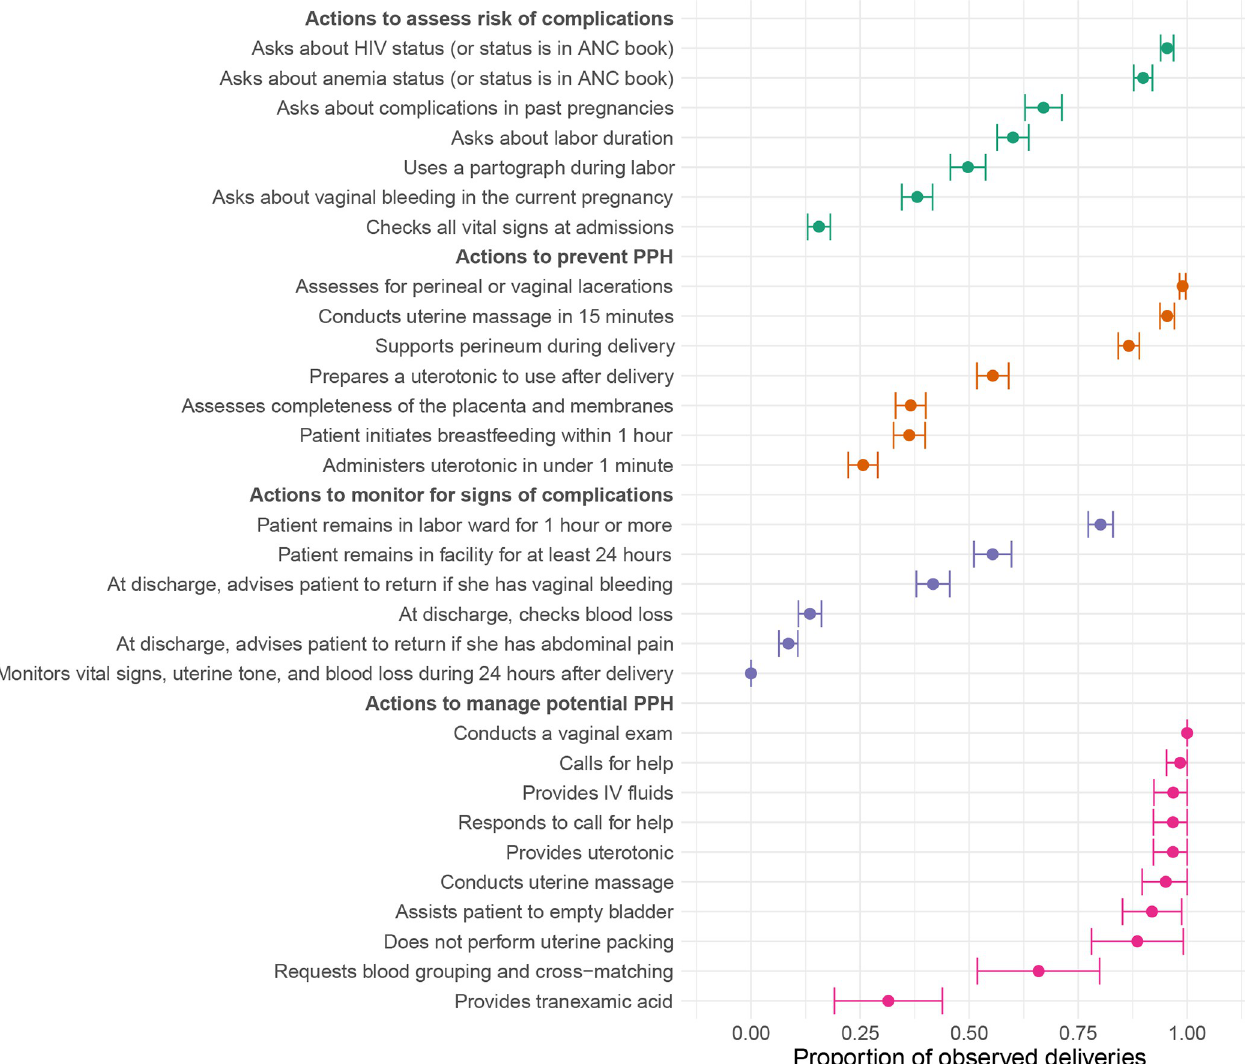
Fig 2. Adherence to guidelines for postpartum hemorrhage prevention, identification, and management. Notes: This figure shows the estimated proportion of observed deliveries in which each listed action was completed with 95% confidence intervals. Colors correspond to different aspects of quality care: Assessing risk of PPH, preventing PPH, monitoring for signs of PPH, and managing suspected PPH.